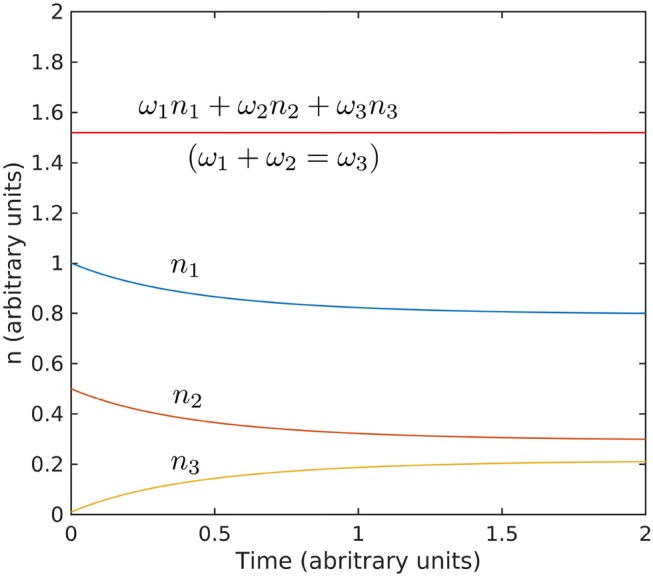
Evolution toward stationarity of the solution of the kinetic Equation 18. The initial conditions used n1(0) = 1, n2(0) = 0.5, and n3(0) = 0.01, and interaction coefficient are arbitrary and exaggerated to highlight the behavior. The Hamiltonian ω1n1 + ω2n2 + ω3n3 is conserved for ω1 + ω2 = ω2 (values for ω are also arbitrary).